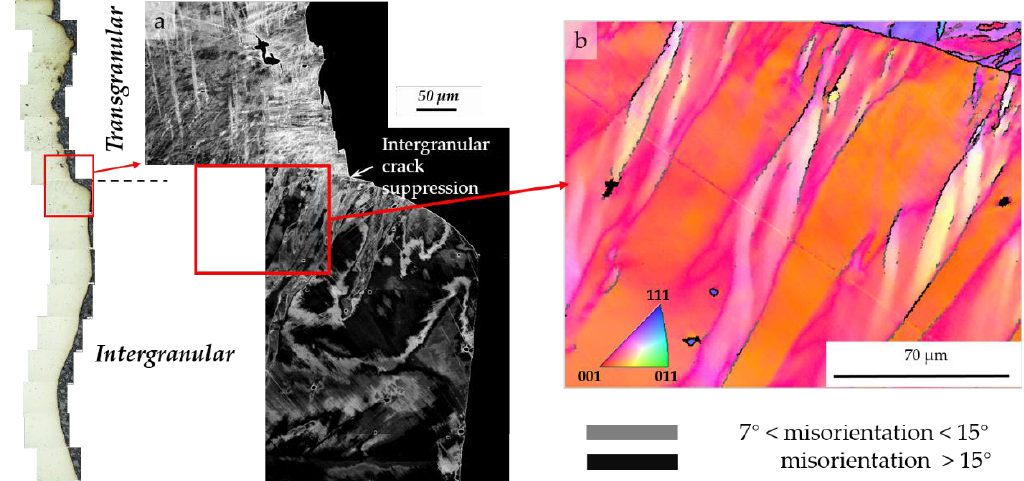
Figure 4. ( a ) ECCI micrograph of the region of fracture mode transition from intergranular to transgranular; ( b ) EBSD inverse pole figure (IPF) map of the region marked by a rectangle in the ECCI micrograph of (a). In (b), colors denote crystal directions normal to the polish plane. Misorientations in the range 7–15° and above 15°, are highlighted using gray and black lines, respectively.